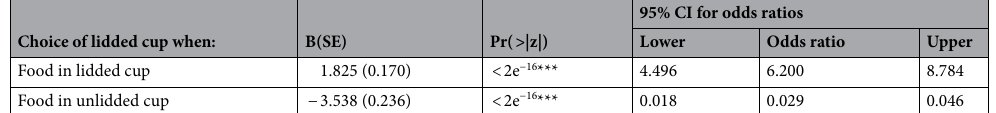
Choice of lidded cup